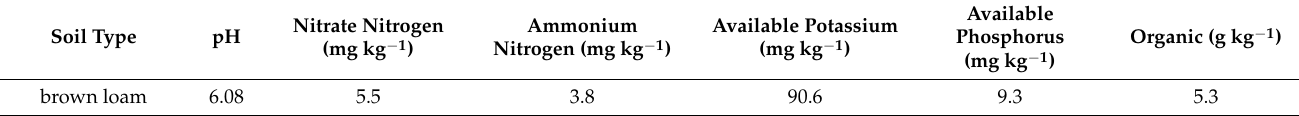
Table 1. The basic characteristics of the test